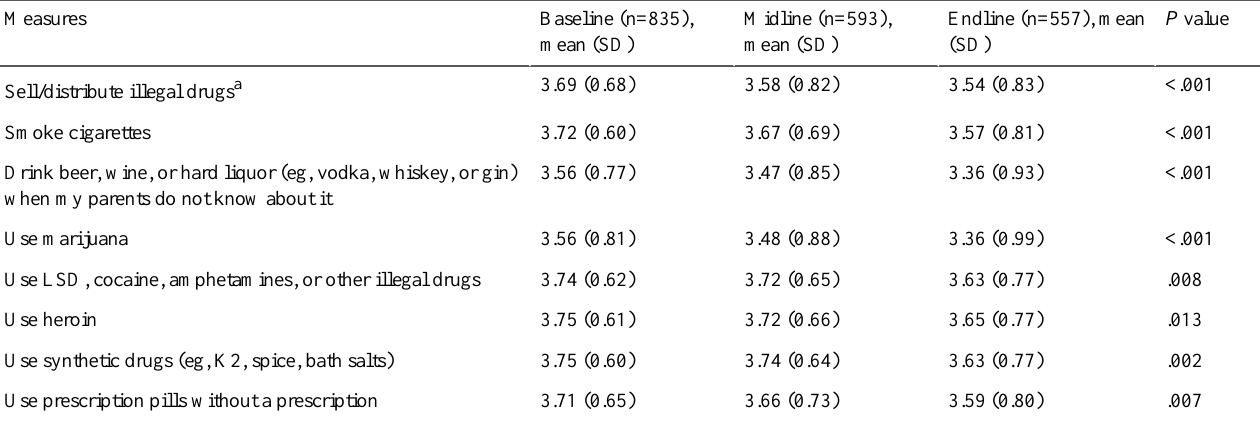
Table 1. Overall mean differences in drug use intentions among all baseline, midline, and endline groups.